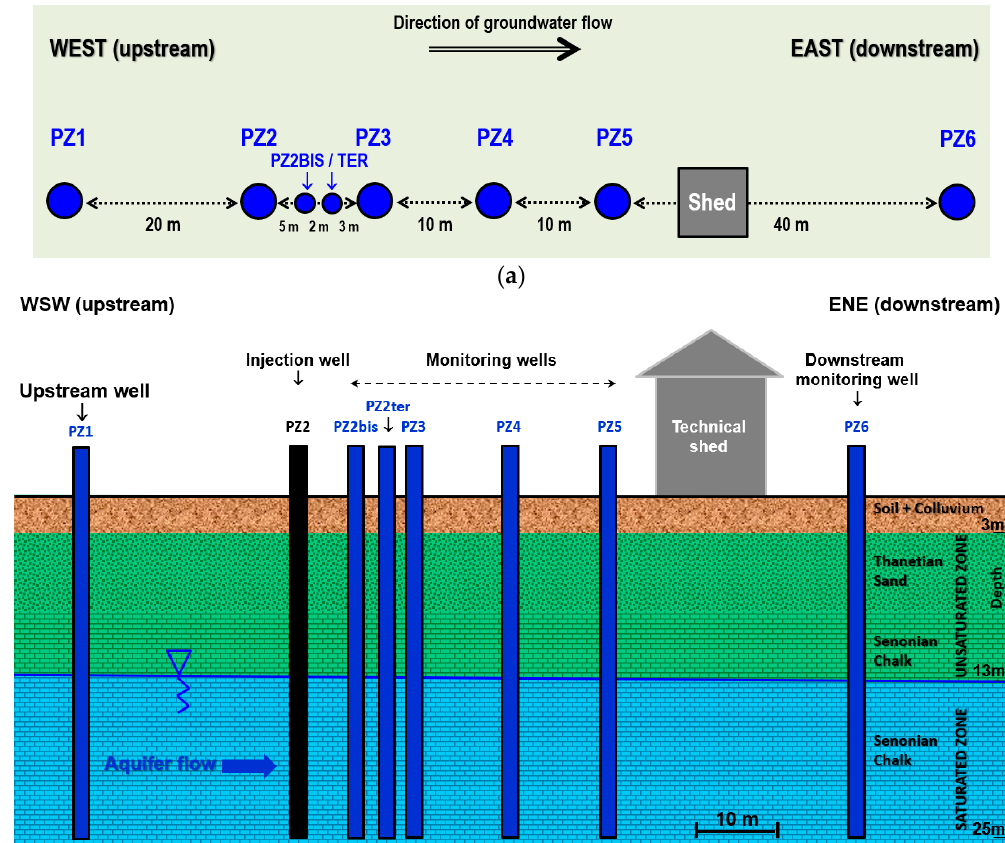
Figure 2. Diagram of the Catenoy experimental site: ( a ) planimetry; ( b ) cross-section.